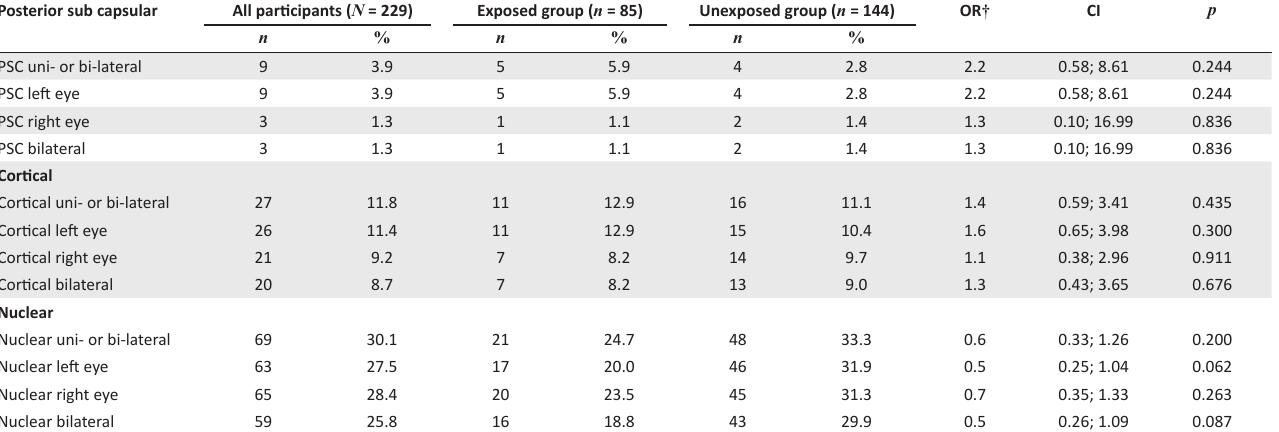
TABLE 3: Description of cataracts after exclusion of participants less than 35 years and less than 5 years’ experience. Posterior sub capsular All participants ( N = 229) Exposed group ( n = 85)